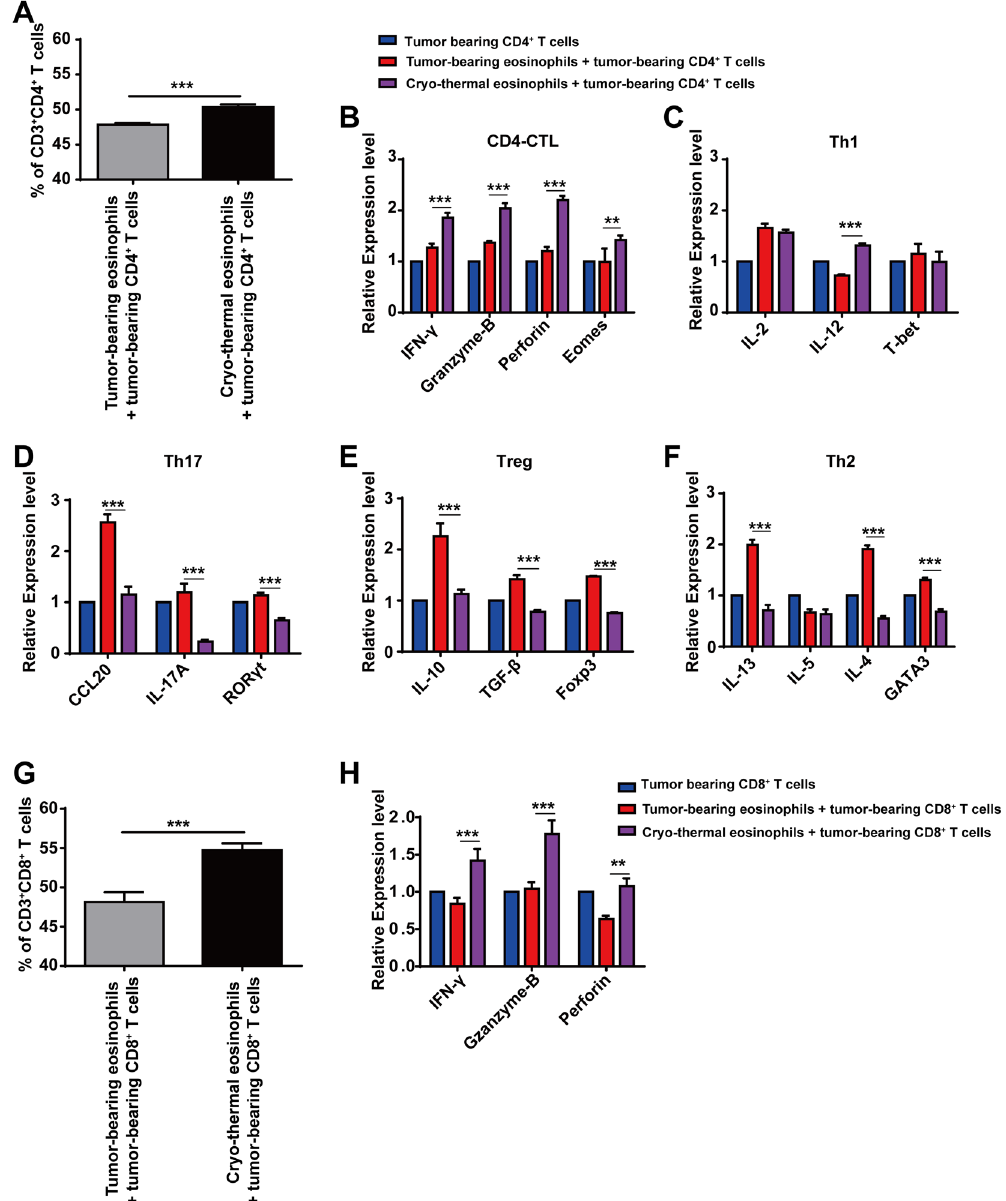
Figure 7. Cryo-thermal-activated eosinophils promoted the cytolytic capacity of CD4 + and CD8 + T cells in vitro . ( A ) The percentage of CD3 + CD4 + T cells after co-cultured with eosinophils were analyzed by flow cytometry. Total RNA was isolated from CD4 + T cells after co-cultured with eosinophils and RT-qPCR analysis was performed to measure the level of CD4-CTL ( B ), Th1 ( C ), Th17 ( D ), Treg ( E ) and Th2 ( F ) cell subsets. ( G ) The percentage of CD3 + CD8 + T cells after co-cultured with eosinophils were analyzed by flow cytometry. ( H ) Total RNA was isolated from CD8 + T cells after co-cultured with eosinophils and RT-qPCR analysis was performed to measure the level of IFN- γ , perforin and granzyme-B. Data was shown as mean ± SD. Data for bar graphs was calculated using student’s t-test ( A , G ) or two-way ANOVA (B-F, H). * p < 0.05; ** p < 0.01; *** p <